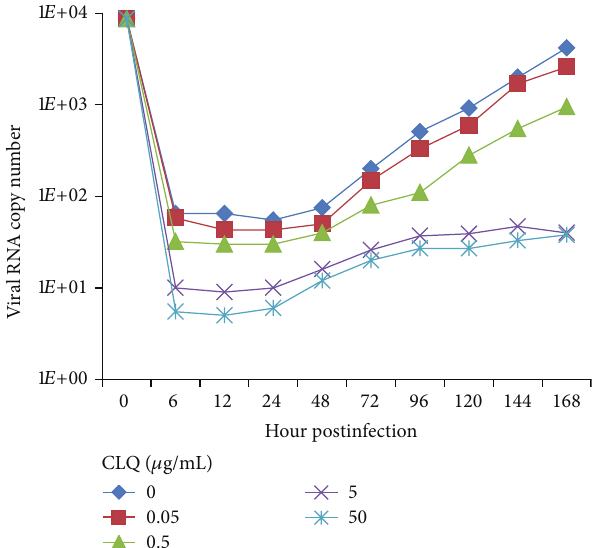
Figure 6: Action of chloroquine added at 12-hour intervals on DENV-2 replication in Vero cells. The viral RNA present in the culture supernatants of Vero cells infected with DENV-2, both untreated and treated chloroquine (every 12 hours after infection), was extracted and analyzed by qRT-PCR. The results represent the average values of the number of copies of viral RNA (𝑃 < 0.01)